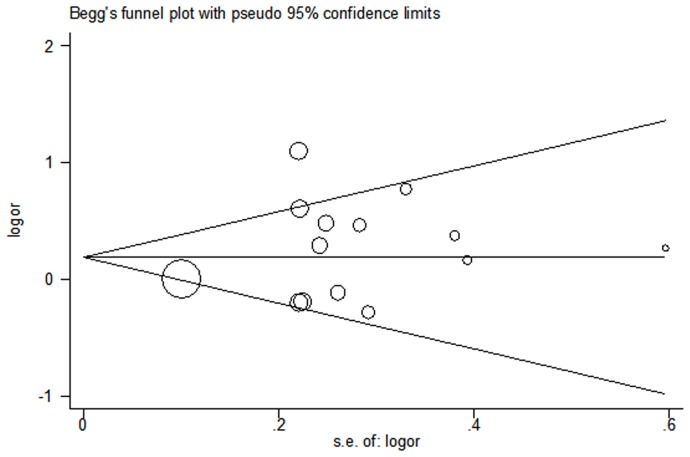
Begg's funnel plot of publication bias test.Each point represents an isolated study for the indicated association. Log (OR): natural logarithm of OR. Horizontal line mean effect size.